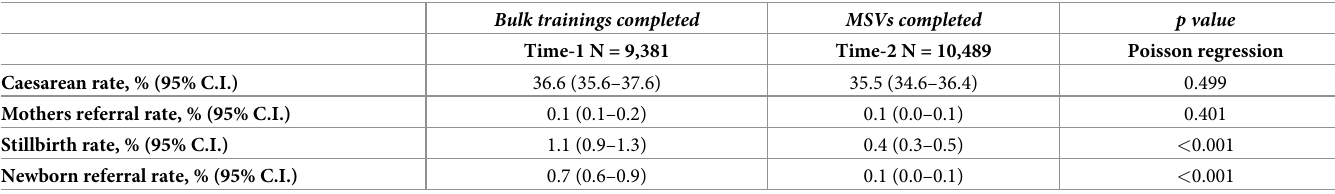
Table 3. Outcomes of obstetric care in the study states, from labour room registers. Bulk trainings completed MSVs completed p value Time-1 N = 9,381 Time-2 N = 10,489 Poisson